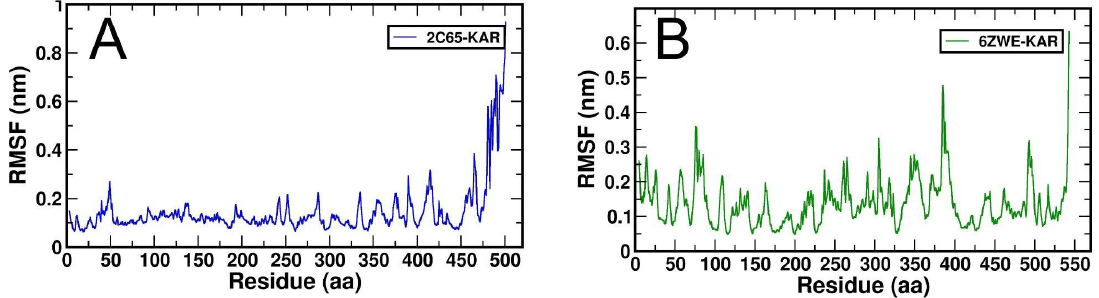
Molecules 2022 , 27 , x FOR PEER REVIEW Figure 7. Generated RMSF plots for both docking complexes from MD simulation at 100 ns. ( A ), RMSF plot of 2C65-KAR and ( B ), RMSF plot of 6ZWE-KAR. Figure 8. Generated Rg plots for both docking complexes from MD simulation at 100 ns. ( A ), Rg plot of 2C65-KAR and ( B ), Rg plot of 6ZWE-KAR. The compactness of the native protein can be determined by the generated Rg-plots. Folding and unfolding of the protein was analyzed by the RG-values at 100 ns time scale for 2C65-KAR and 6ZWE-KAR docking complexes (Figure 8A,B). However, the 2C65-KAR docking complex Rg-plot is comparatively less stable than 6ZWE-KAR. Similarly, the SASA plots indicated the compactness of in form of native constant of the target protein after interaction with an inhibitor mainly hydrophobic interaction.